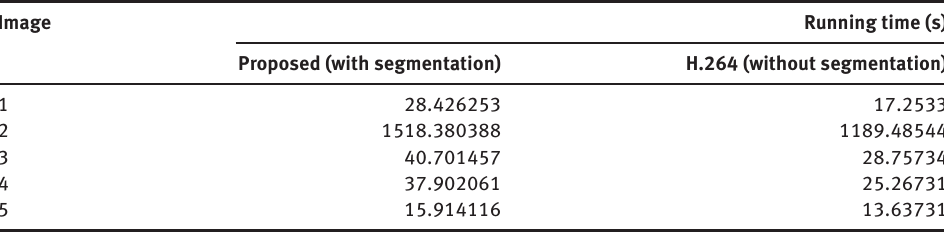
Table 3: Running Time of Proposed Segmentation-based Compression and Existing H.264 Compression